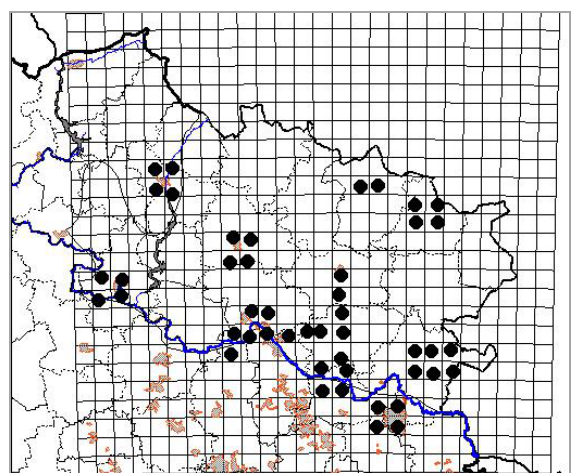
Fig. 10. The map of the distribution of Capsella bursa-pastoris (L.) Medic. in the Starobilsk grass-meadow steppe